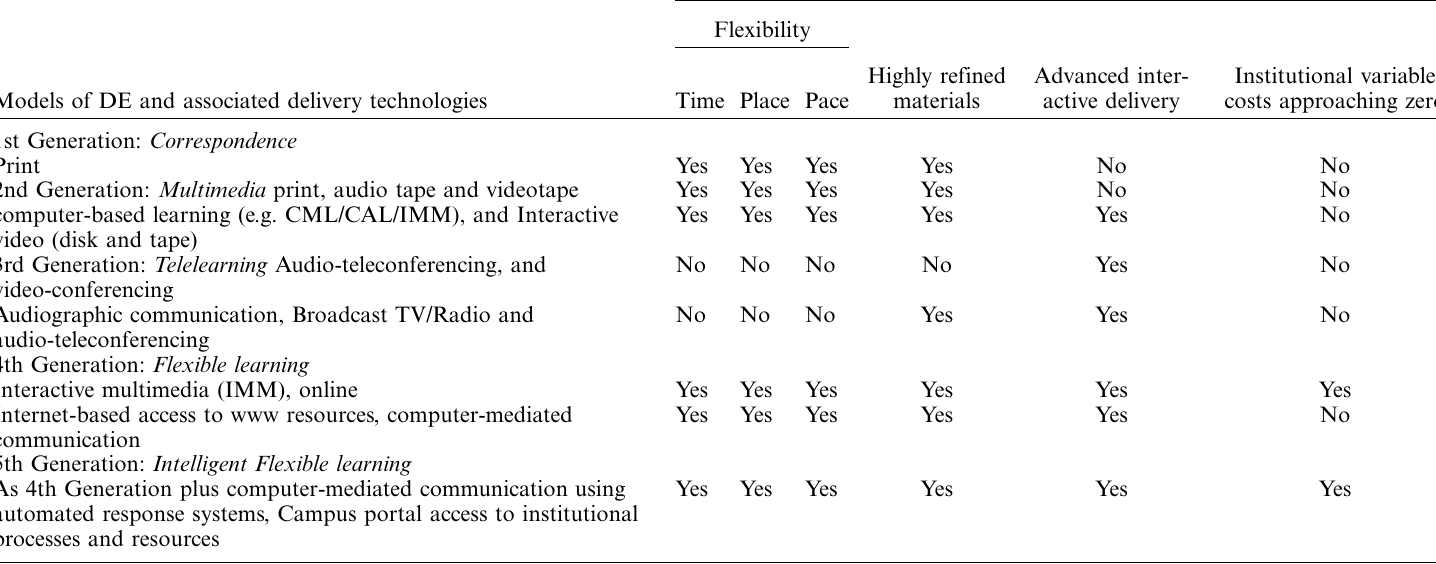
Table 1. Generations of